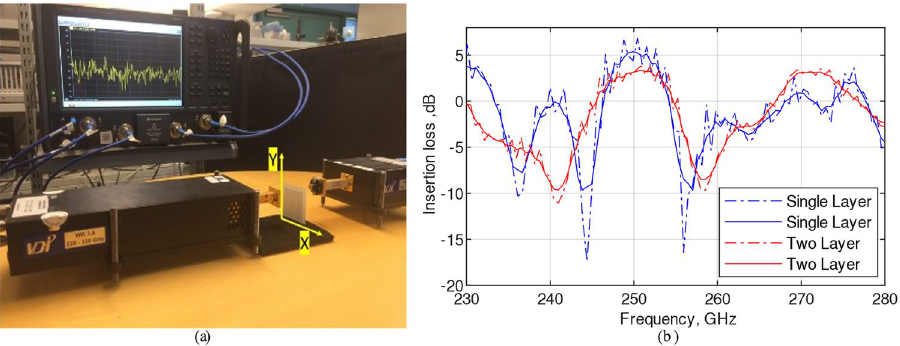
Figure 8. Insertion loss was measured by placing the filter between the waveguide and horn antenna as in ( a ) and ( b ) shows the measured signal in dashed line. The solid line is smoothed version.